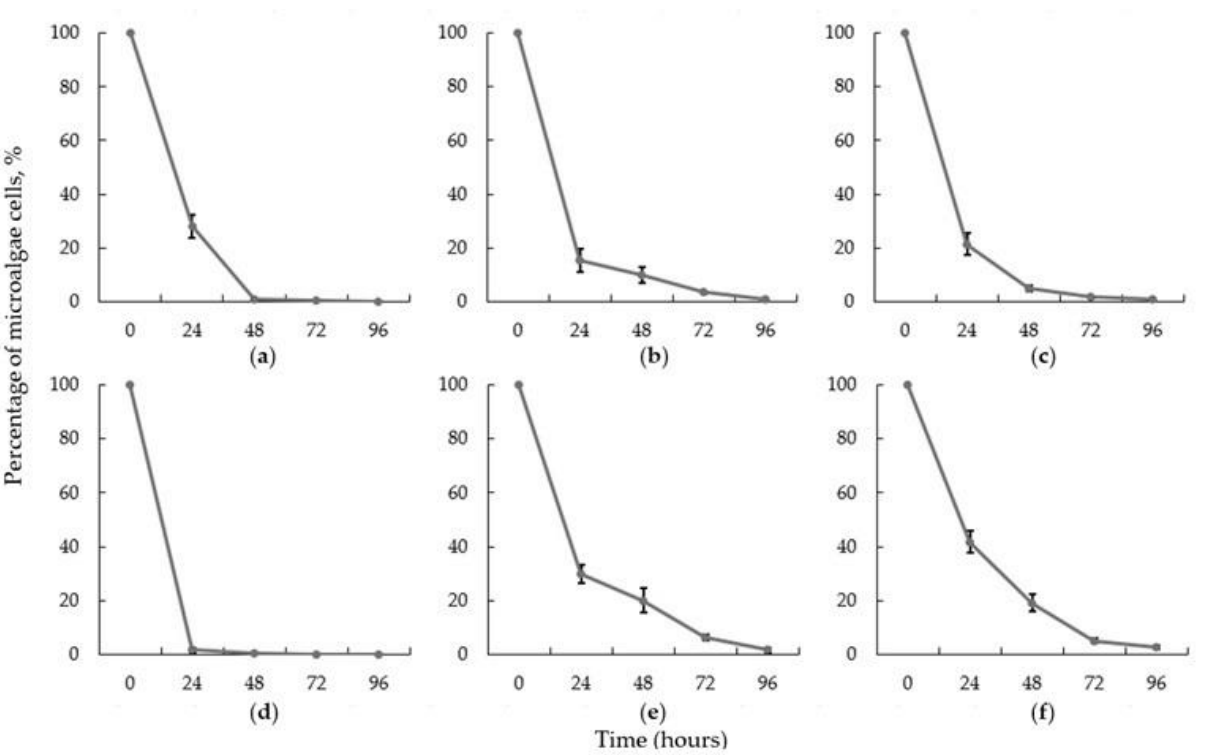
Figure 5. T. obliquus harvesting efficiency at pH levels: ( a ) 4; ( b ) 5; ( c ) 6; ( d ) 7; ( e ) 8; ( f ) 9 with I. lacteus pellets. Standard deviation represents the average from three replicates.